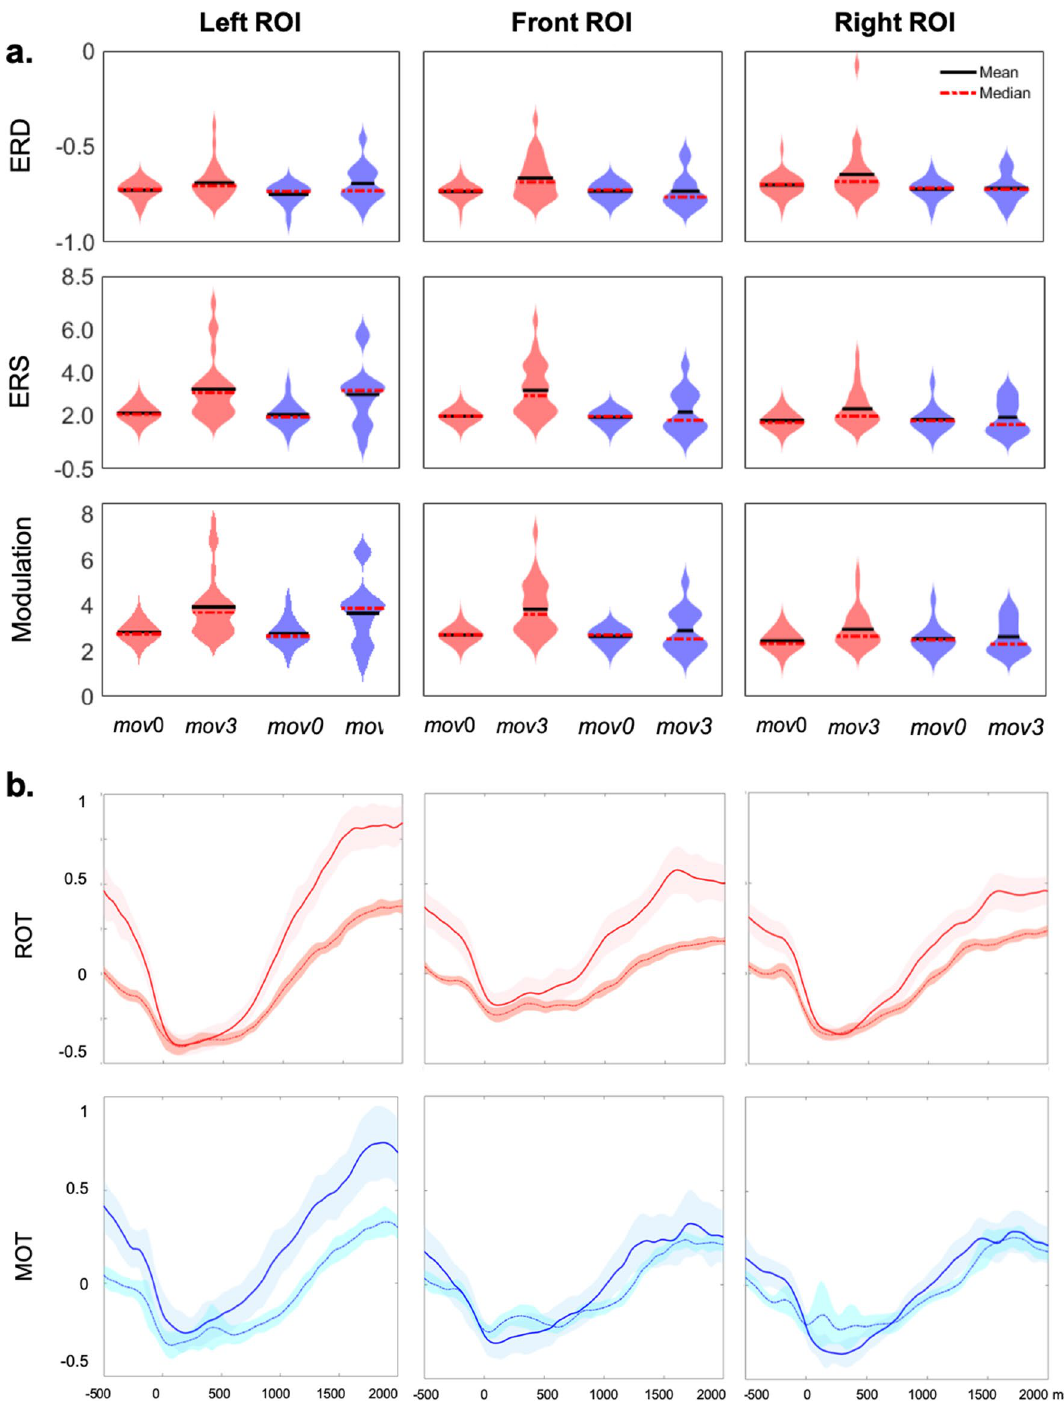
Figure 4. ( a ) Violin plots showing the data distribution and probability density of ROT mov (in red) and MOT mov (in violet). ( b ) Time-course of beta oscillatory activity during ROT mov (in red) and MOT mov (in blue) for Block 1 (thin, dotted line) and Block 3 (thick, solid line)